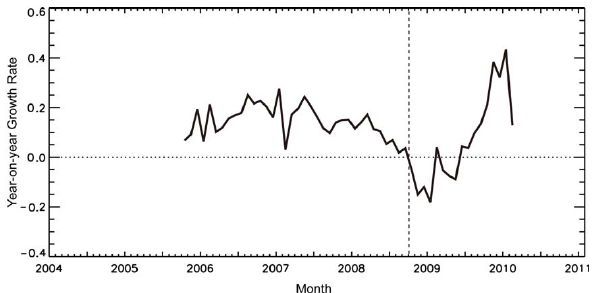
Fig. 1. Year-on-year growth rate in monthly thermal power gener- ation in China. The value for a particular month is calculated as its percentage difference from the same month of the previous year. The vertical dashed line denotes the start of negative growth in ther- mal power